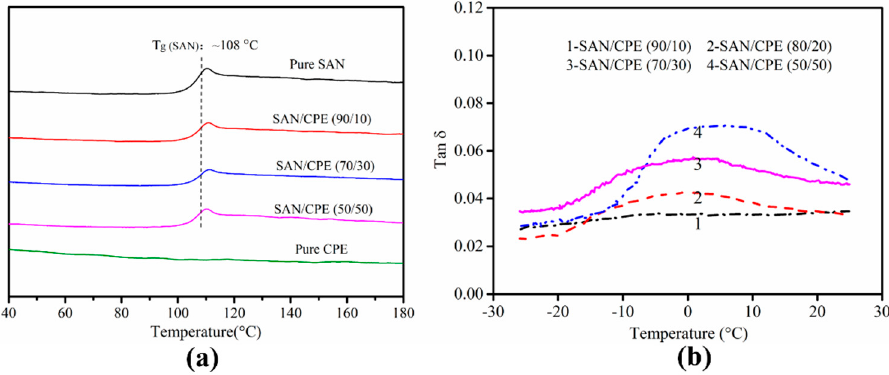
Figure 4. ( a ) DSC scanning curves of neat SAN, neat CPE and SAN/CPE blends; ( b ) The loss factor curves of SAN/CPE blends from DMA scanning.